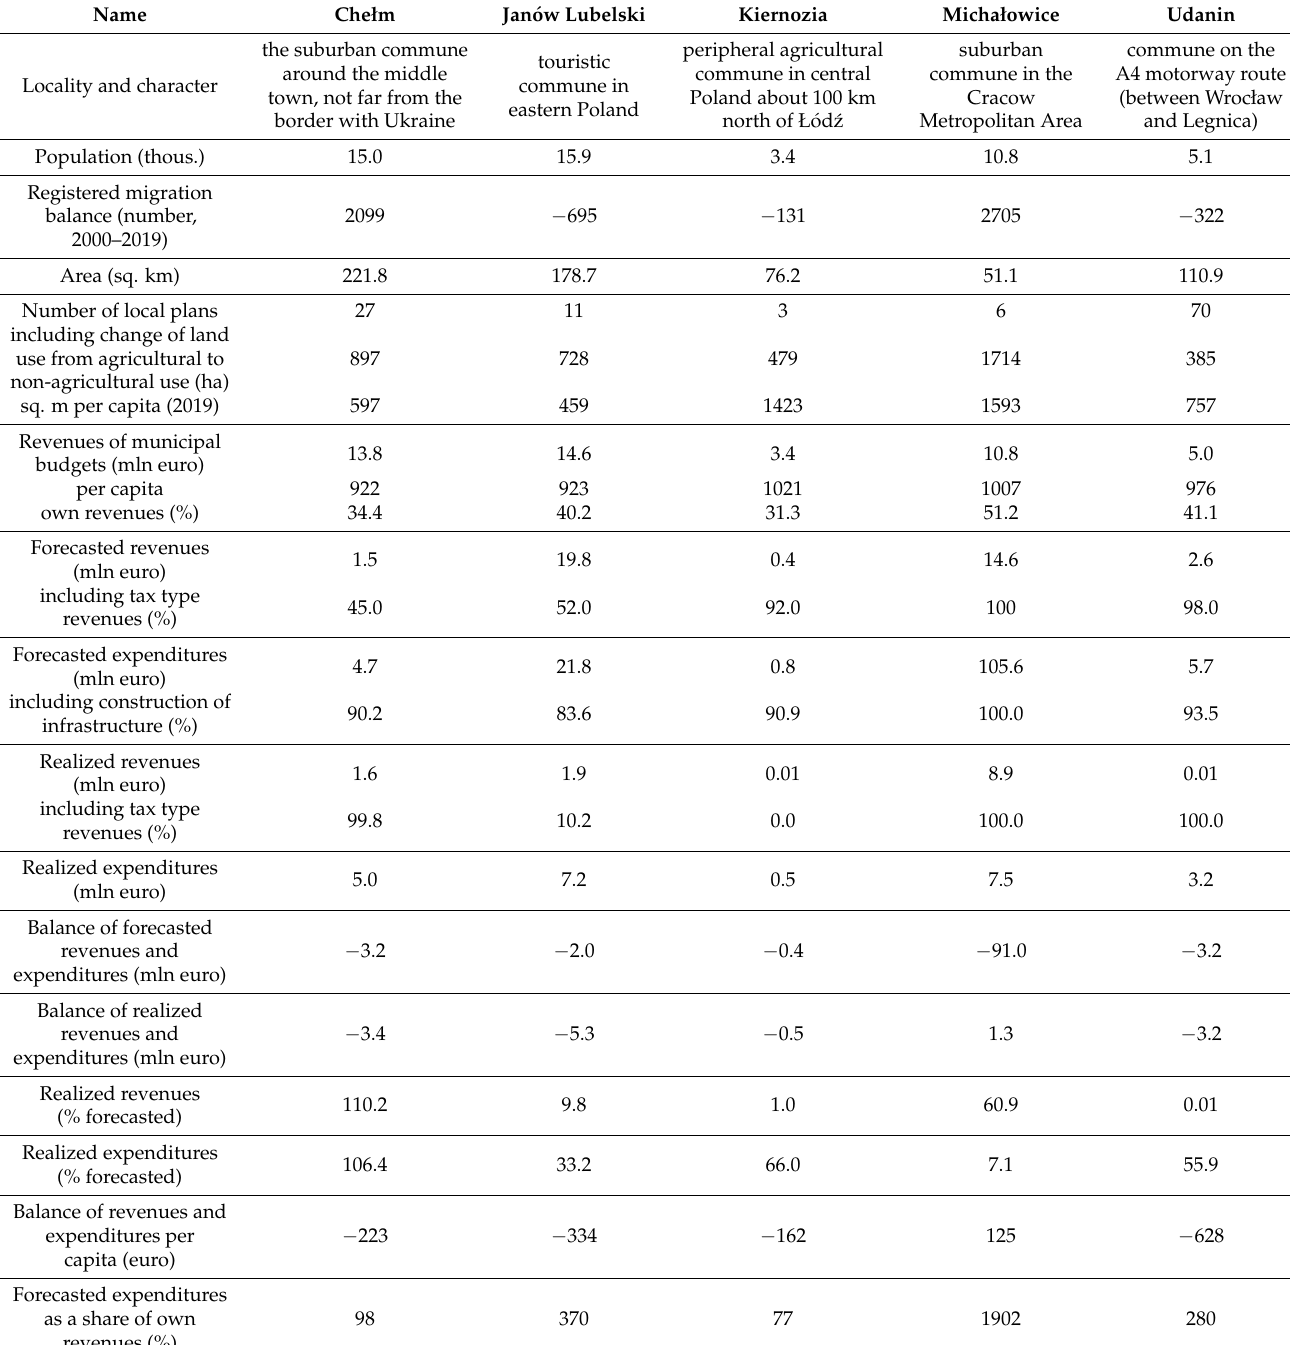
Table 3. Data on the forecasted and realized revenues and expenditures in the 5 selected communes in Poland. As of 31 December